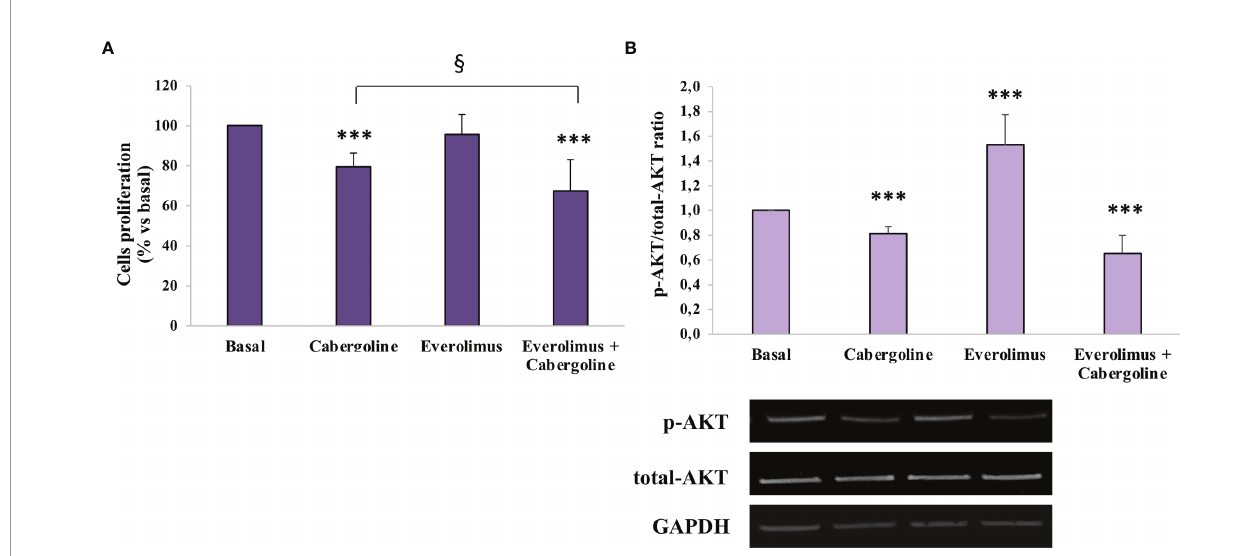
FIGURE 2 | Cabergoline and everolimus cotreatment reduced both cell proliferation and AKT phosphorylation in MMQ cells. MMQ cells were cultured with 100 nM cabergoline and 1 nM everolimus for 72 h (A) or 3 h (B) , administered singularly or in combination. (A) BrdU incorporation in newly synthesized DNA was measured. The experiments were repeated 4 times, and each determination was done in quadruplicate. Values represent mean (± SD) normalized vs. respective basal. *** p < 0.001 vs. corresponding basal; § p < 0.05 vs. cabergoline administered alone. (B) The graph shows the quanti fi cation of p-AKT on Ser473 normalized to total AKT (mean value ± SD from 4 independent experiments). Representative immunoblots are shown. *** p < 0.001 vs. corresponding basal.